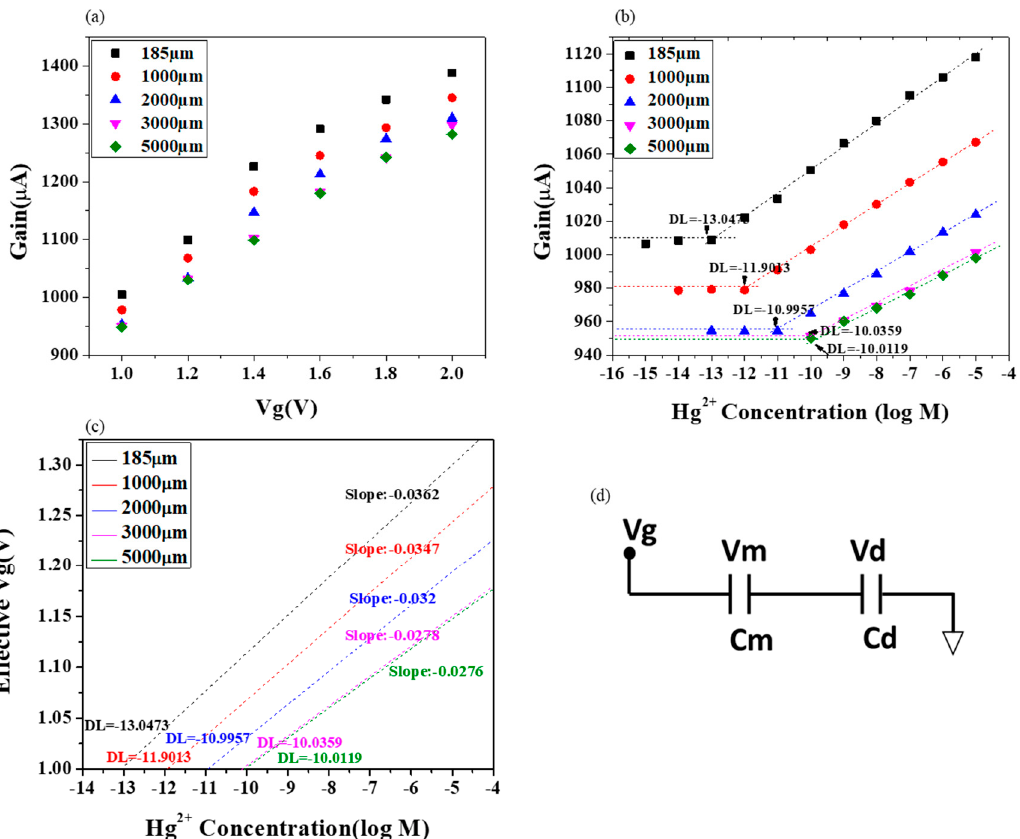
Figure 5. Mercury ion detection using extended gate Hg-ISMFET and sensitivity comparison. ( a ) Gain of Hg-ISMFET versus gate voltage ( b ) Gain of Hg-ISMFET versus log mercury ion concentration. ( c ) Effective gate voltage obtained with respect to log mercury ion concentration. ( d ) Schematic representation of the capacitive model of the sensor.